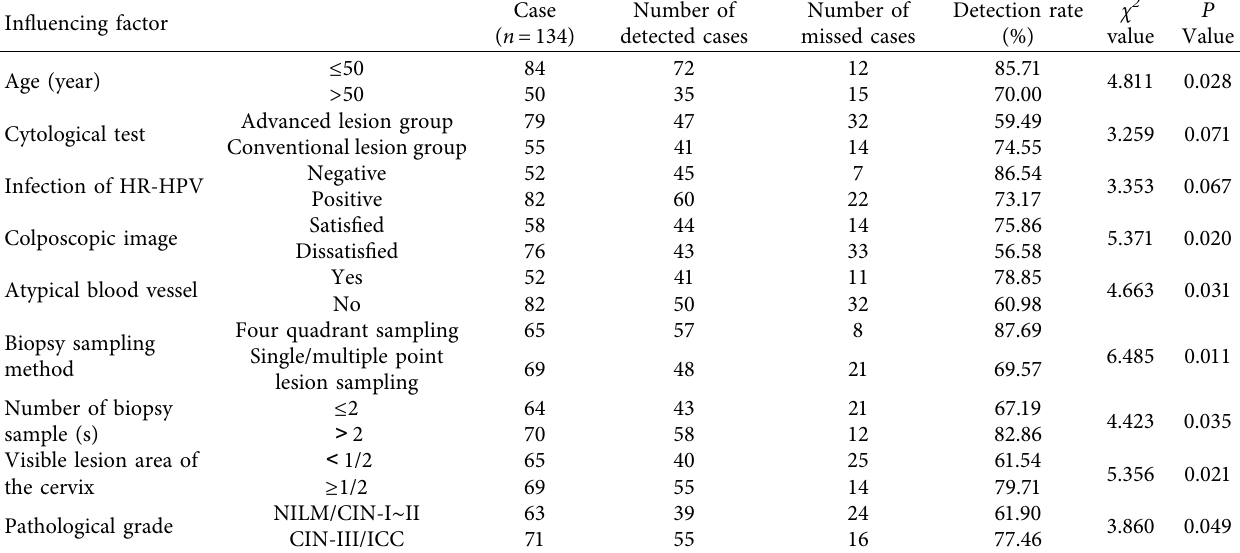
Table 1: Single-factor analysis of influencing the detection of CIN and ICC in the colposcopic